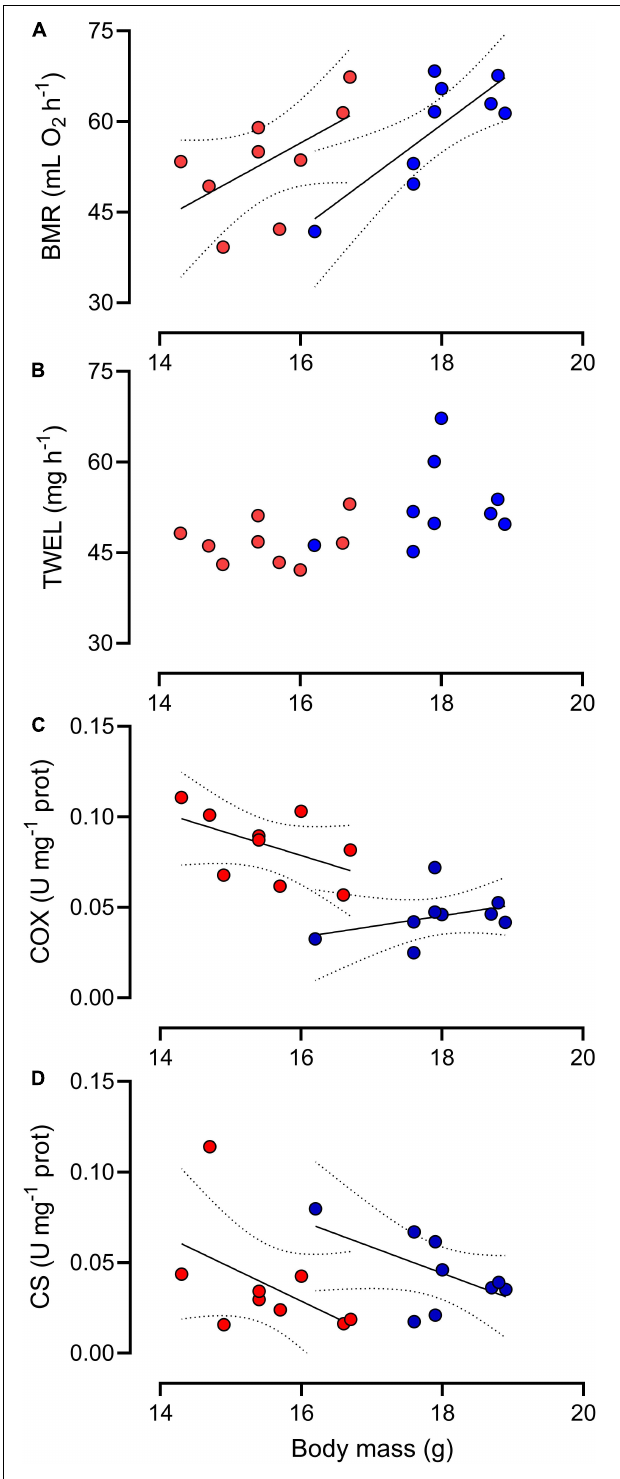
FIGURE 3 | Basal metabolic rate (A) , total evaporative water loss (B) , cytochrome c-oxidase (C) , and citrate synthase (D) activities in erythrocytes as a function of body mass in Z. capensis individuals acclimated to control (blue symbol) and water restriction (red symbol) conditions. Lines indicate significant differences between hydrated and dehydrated